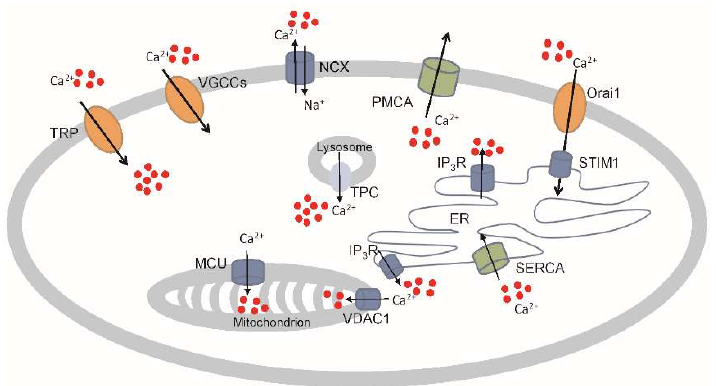
Figure 1. Examples of Ca 2 + -permeable channels, pumps, and plasma membrane and intracellular organelles exchangers. Ca 2 + entry from the extracellular space is mediated by plasma membrane channels including Transient Receptor Potential channel (TRP ) and Voltage-Gated Ca 2 + Channel (VGCC), and the plasma membrane transporters such as NCX (Na + / Ca 2 + exchanger) and PMCA (Plasma Membrane Ca 2 + -ATPase) allow for the removal of Ca 2 + from the cytoplasm. Upon the depletion of internal Ca 2 + stores, a particular way of Ca 2 + entry is through the store-operated calcium entry (SOCE) channels, Orai1 (Ca 2 + release-activated Ca 2 + modulator 1), and STIM (Stromal Interaction Molecule). The movement of Ca 2 + toward intracellular stores and the cytoplasm occurs by intracellular calcium channels and transporters as well as endoplasmic reticulum channels, IP 3 R (Inositole 3 Phosphate Receptor) and RyR (Ryanodine Receptor), and transporters, SERCA (Sarco / Endoplasmic Reticulum Ca 2 + -ATPase); mitochondrial transporter, MCU (Mitochondrial Ca 2 + Uniporter) and channels, VDAC1 (Voltage Dependent Anion Channel 1); and lysosomal channel, TPC (Two-porte channel).